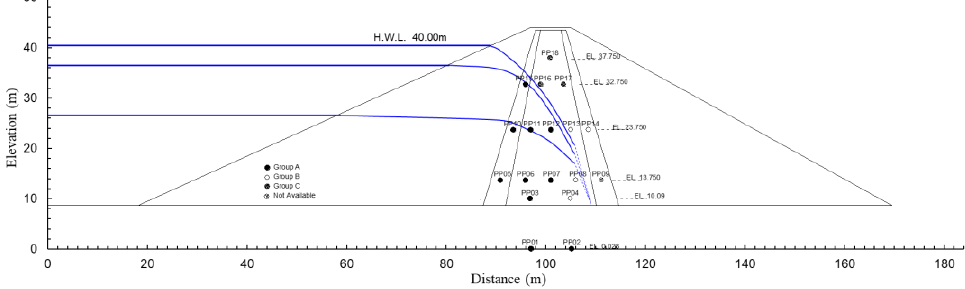
Figure 11. Expected phreatic line drawn from measured porewater pressures.